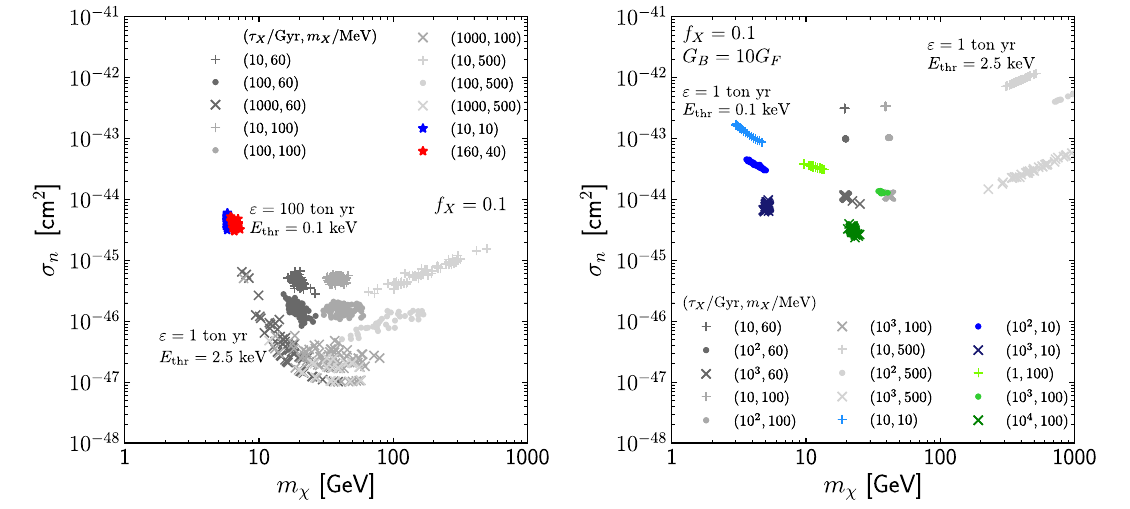
excluded combinations of (τ X , m X ) for an exposure of 1 ton year and threshold of E thr = 2 . 5 keV. The colored points show allowed combi- nations of (τ X , m X ) for an exposure of 100 ton year and threshold of E thr = 0 . 1